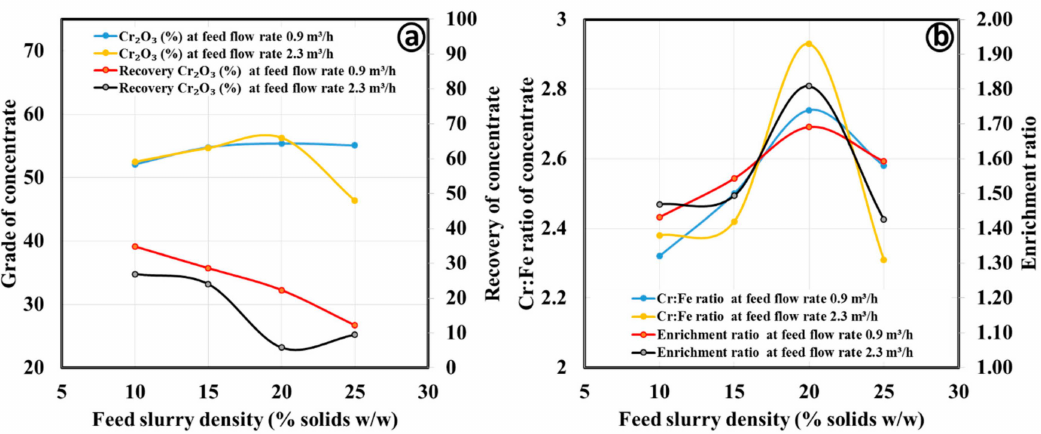
Figure 11. Influence of the feed flow rate and slurry density on the treatment of ultrafine concentrate by the spiral HG10i design ( a ) for grade and recovery; ( b ) for Cr:Fe ratio and enrichment ratio of